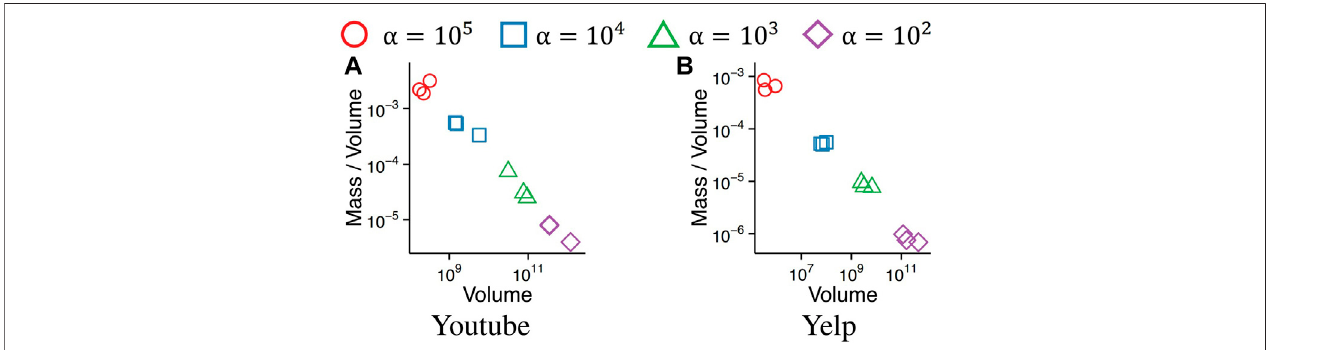
FIGURE 8 | Subtensors detected by D-CUBE are con fi gurable by the parameter α in density metric ρ es ( α ) . As α increases, D-CUBE spots smaller but more compact subtensors.